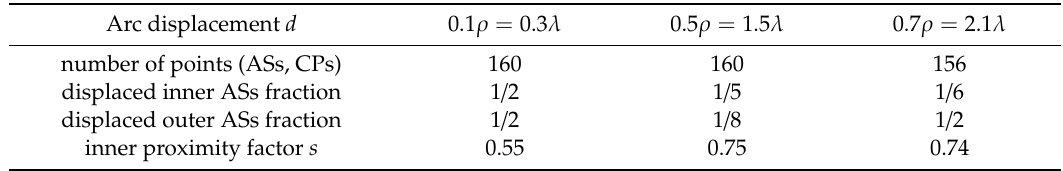
Figure 13. Non-symmetric scatterer: ( a ) geometry and conformal auxiliary surfaces; ( b ) geometry and improved auxiliary surfaces; ( c ) conformal ∆ E and ∆ H error; ( d ) improved ∆ E and ∆ H error; ( e ) conformal RCS; and ( f ) improved RCS. Table 1. Geometry definition, method of auxiliary sources (MAS) parameters, and computed BC error of the electromagnetic